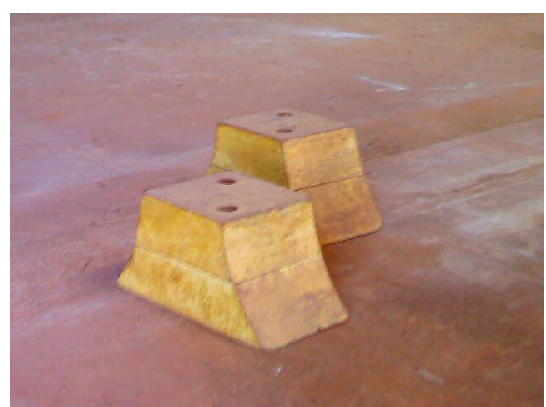
Figura 6- Bloco de partida de madeira com apoio dos pés separados (Fonte: Própria).